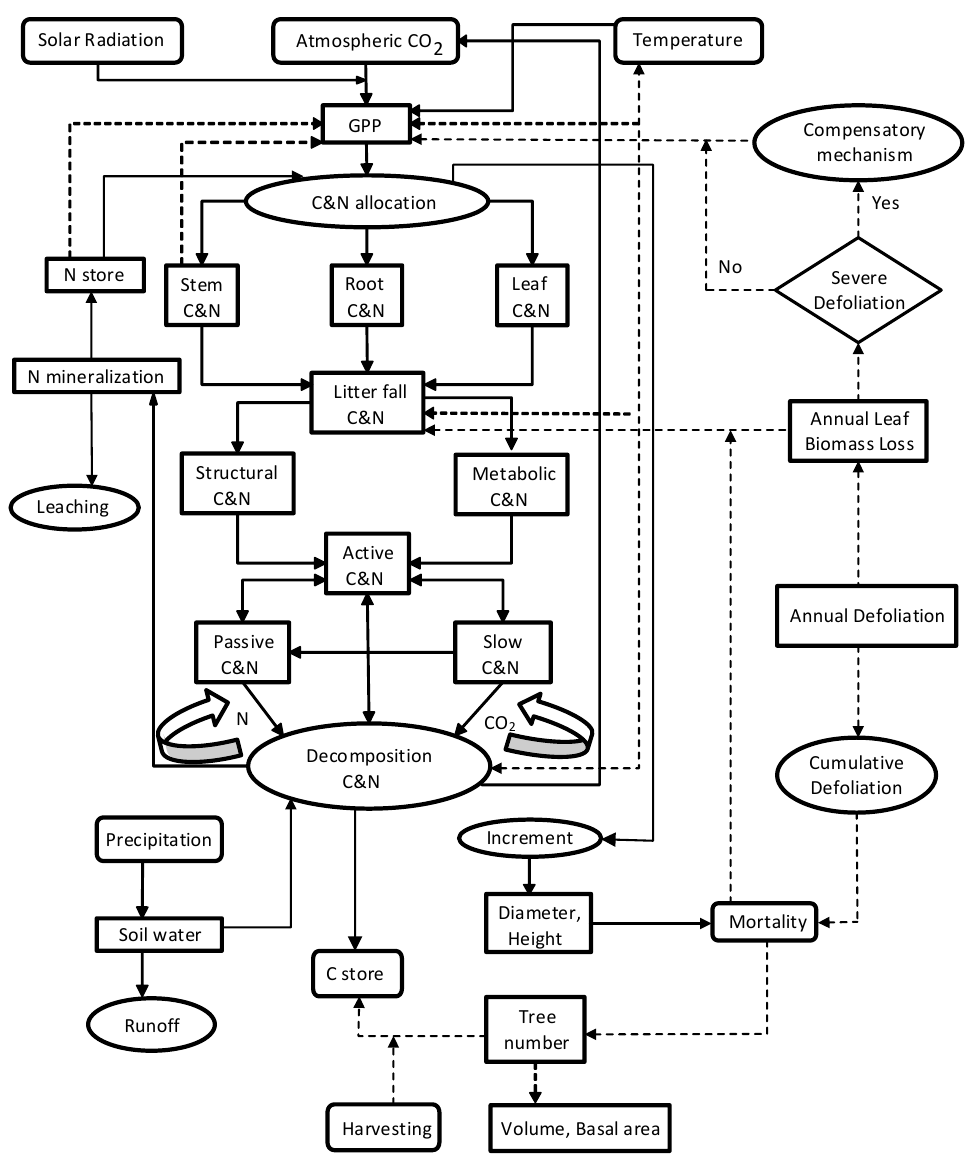
Figure 1. Framework and flow chart of TRIPLEX-Insect model (modified from Peng et al. (2002) [25]). Rectangles represent pools or state variables; ovals represent simulated processes; diamond-shaped boxes represent judgment process; dotted lines represent controls; and solid lines represent carbon (C), nitrogen (N), and water flow.